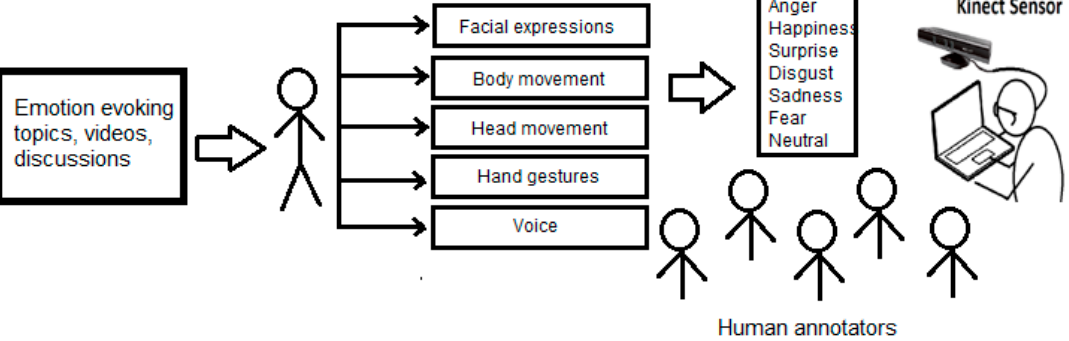
Figure 2. Spontaneous emotion data collection and annotation process using Kinect